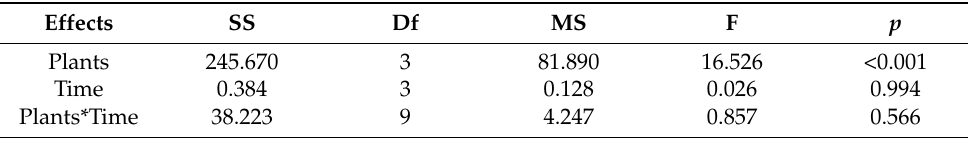
Table 1. Results of two-factor ANOVA for the behavioral preference of Orius sauteri females to four plant species over time.